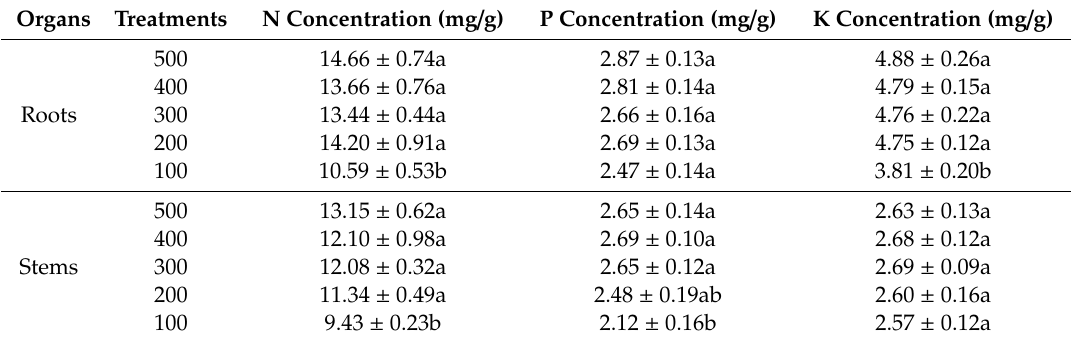
Table 2. Nutrient concentration of root and stem in P. chinensis under specific nutrient treatment conditions at the end of the growing season.